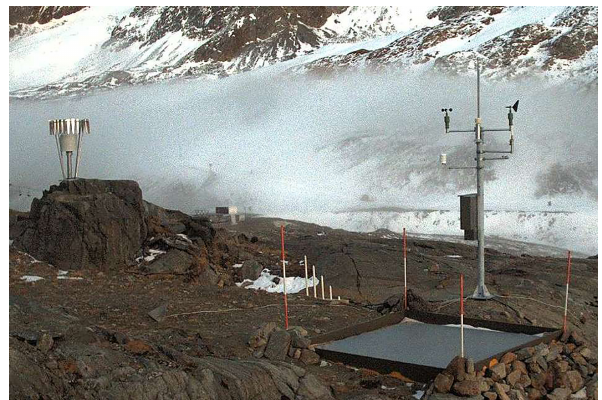
Figure 12. Webcam picture of the Bella Vista weather sta- tion (2805ma.s.l., 46.78284 ◦ N, 10.79138 ◦ E), view to the East. Left: Ott Pluvio 2 with wind shelter. Center: temperature profiler. Right: snow pillow (foreground) and mast with sensors (back- ground) for wind speed and direction, snow height, tempera- ture/humidity and radiative fluxes. The most recent picture is avail- able at http://alpinehydroclimatology.net.